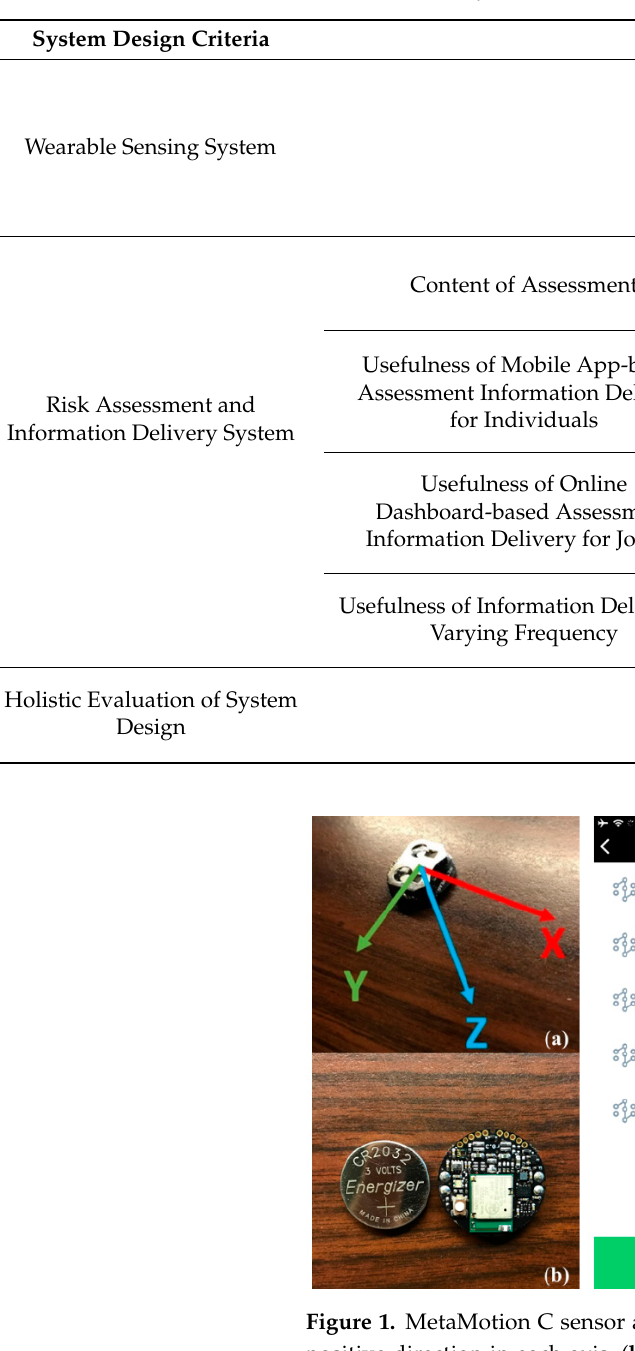
configuring sensors on a